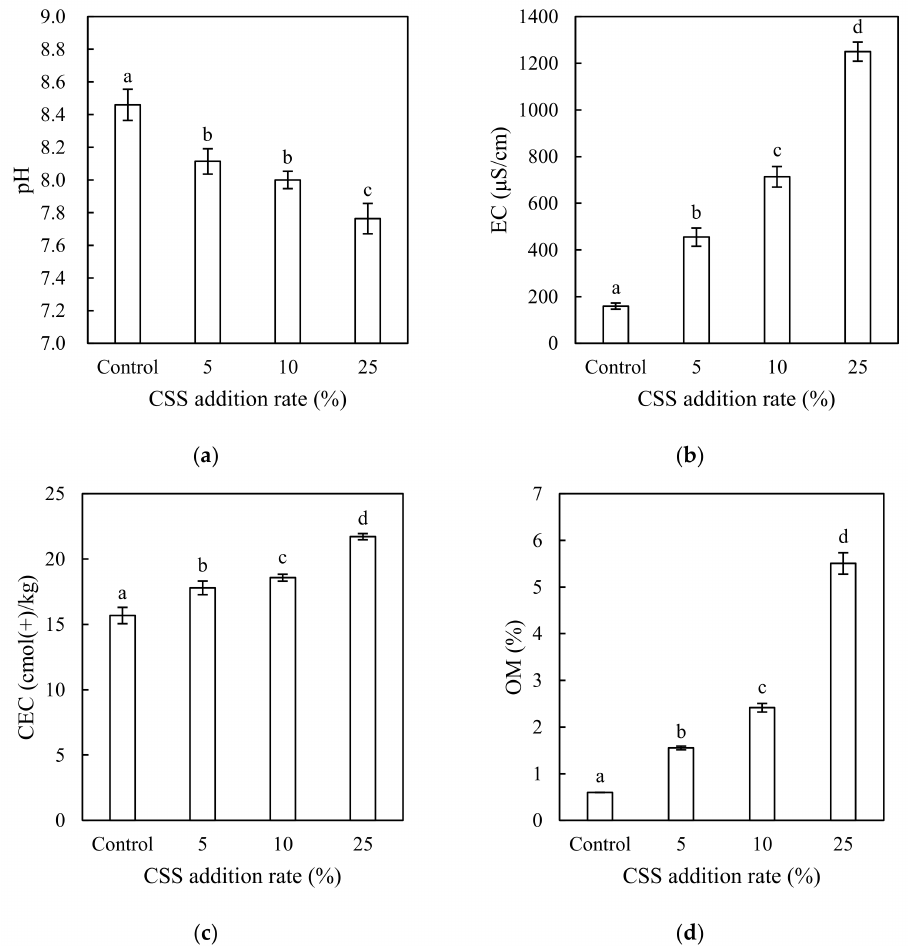
Figure 1. ( a ) pH of the control and amended soil; ( b ) electrical conductivity (EC) of the control and amended soil; ( c ) cation exchange capacity (CEC) of the control and amended soil; ( d ) organic matter (OM) of the control and amended soil. For a given property, the columns labelled with the same letter were not significantly different at a significance level of p < 0.05 by the least significant difference (LSD) test. The error bars represent one standard deviation ( n = 3). CSS: composted sewage